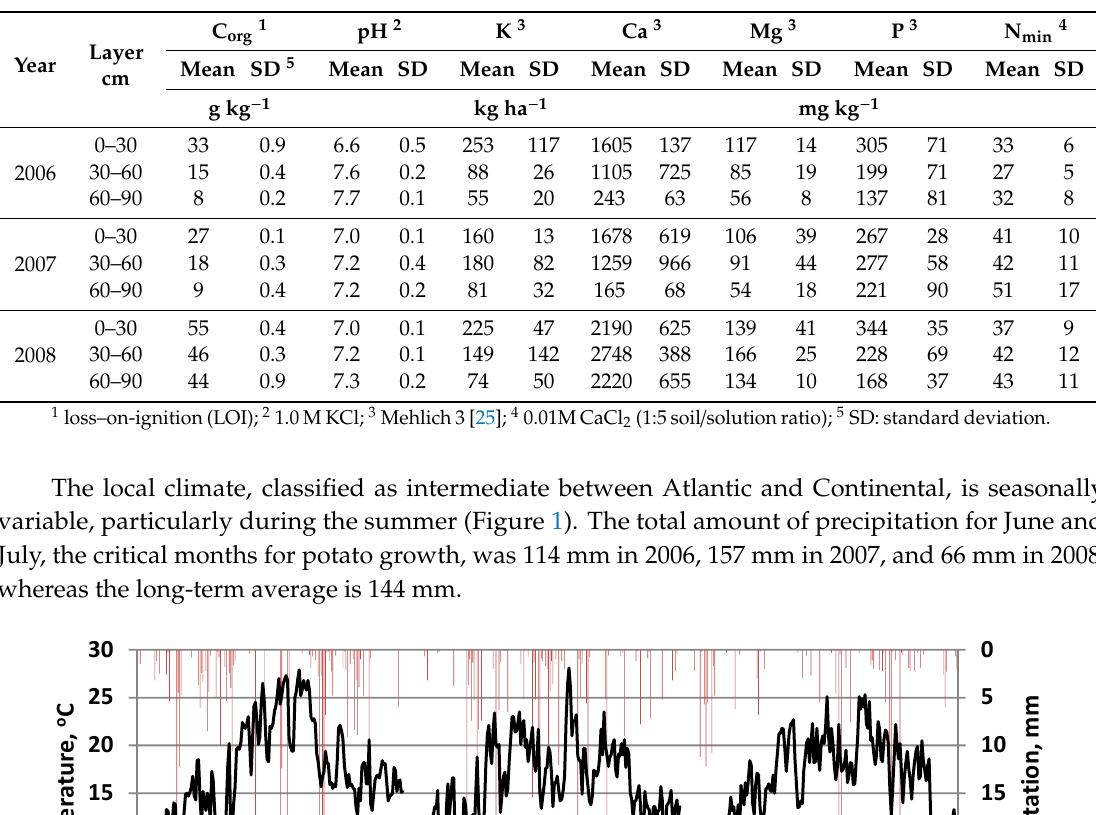
Table 1. Soil fertility indicators before the experiment setup.